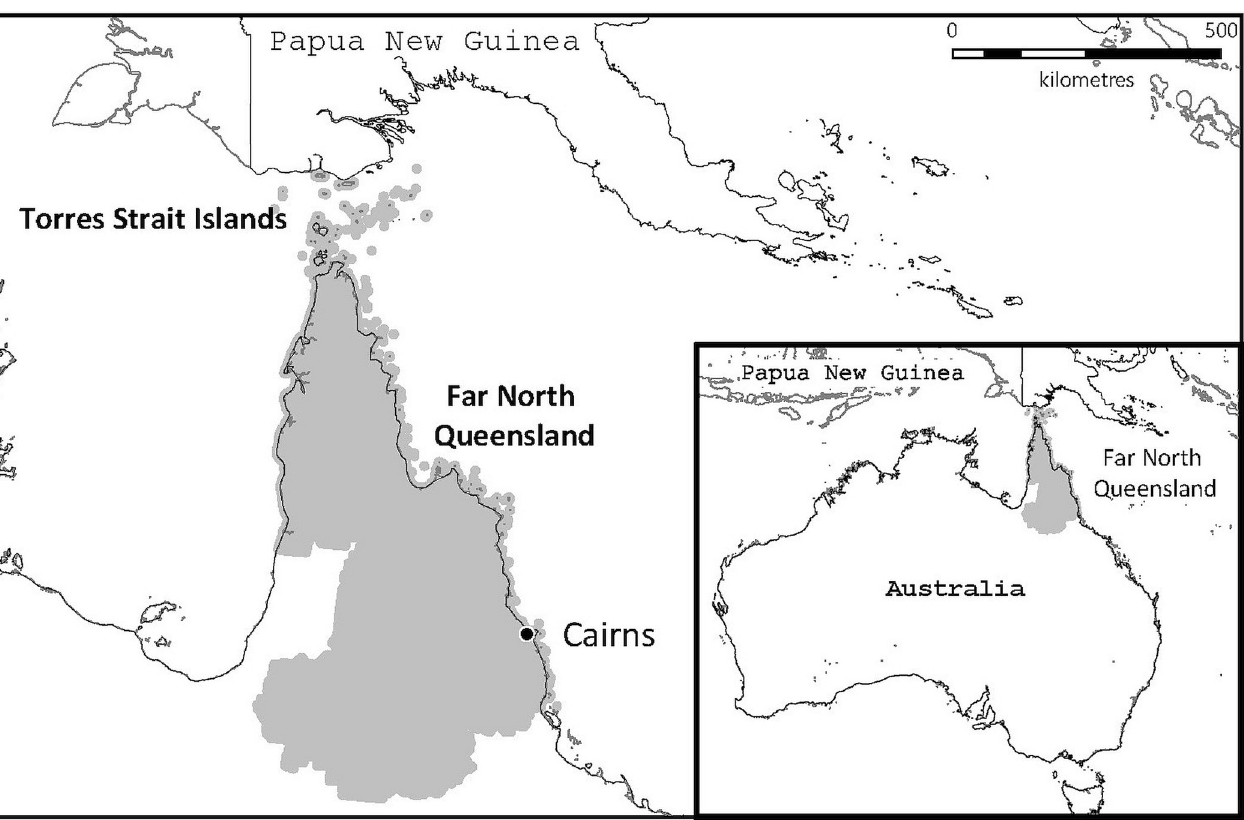
Fig 1. The study region of Far North Queensland in tropical Australia. The map was constructed using mapping software (MapInfo version 15.02, Connecticut, USA) using data provided by the State of Queensland (QSpatial). Queensland Place Names—State of Queensland (Department of Natural Resources, Mines and Energy) 2019, available under Creative Commons Attribution 4.0 International licence https://creativecommons.org/licenses/by/4.0/. ‘Coastline and state border–Queensland—State of Queensland (Department of Natural Resources, Mines and Energy) 2019, available under